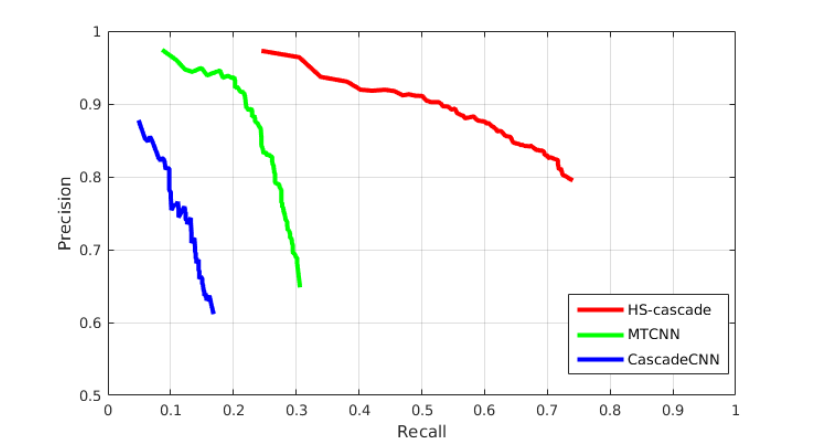
Figure 10. Evaluation on the “Shanghaitech dataset”.